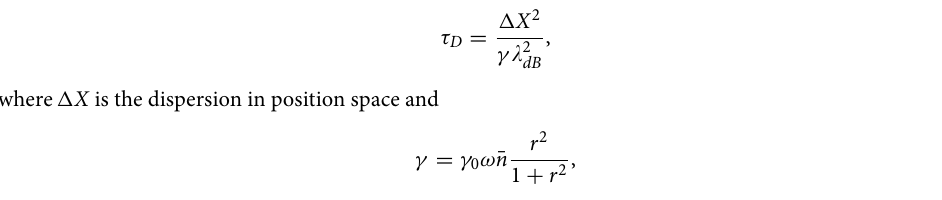
0 , 1 2 and states versus time, with ω | � | � | � 1 and c 0.5 10 7 s 2 γ − = × =